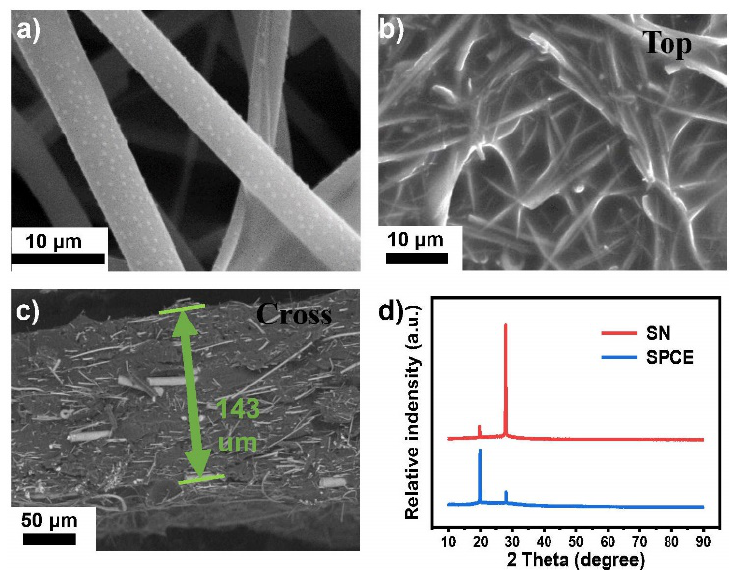
Figure 2. SEM images of ( a ) glass fiber film, the upper ( b ) and the cross-section ( c ) of SPCE film. ( d ) XRD patterns of SN and SPCE.